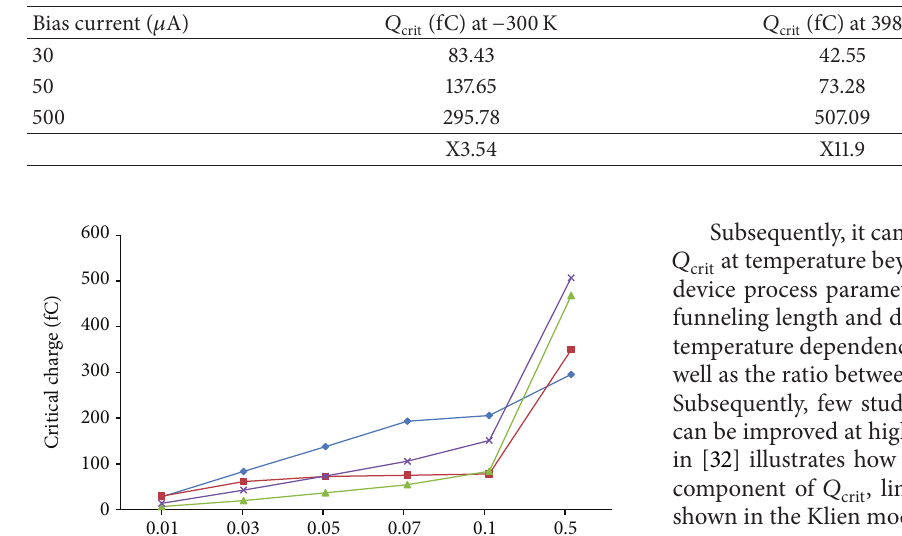
Table 3: 𝑄 improvement with temperature for different bias currents at 𝑉 crit